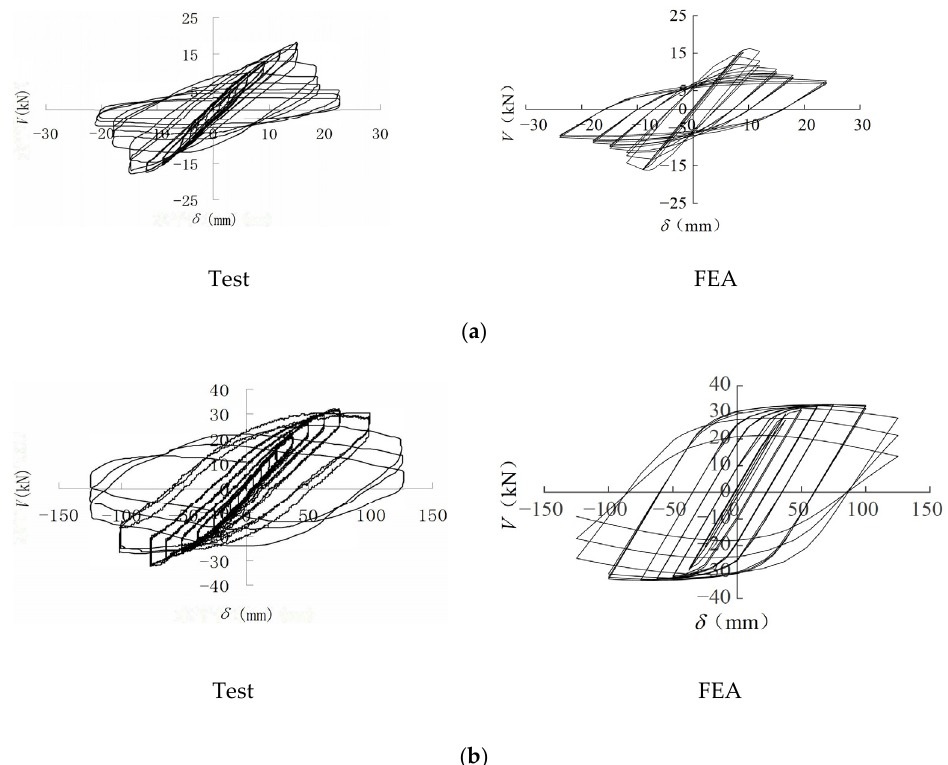
Figure 4. Comparison on hysteresis curves between test and FEA. ( a ) Hysteresis curve of C1-BC-L30-70-02; ( b ) Hysteresis curve of C2-BC-L60-35-02.